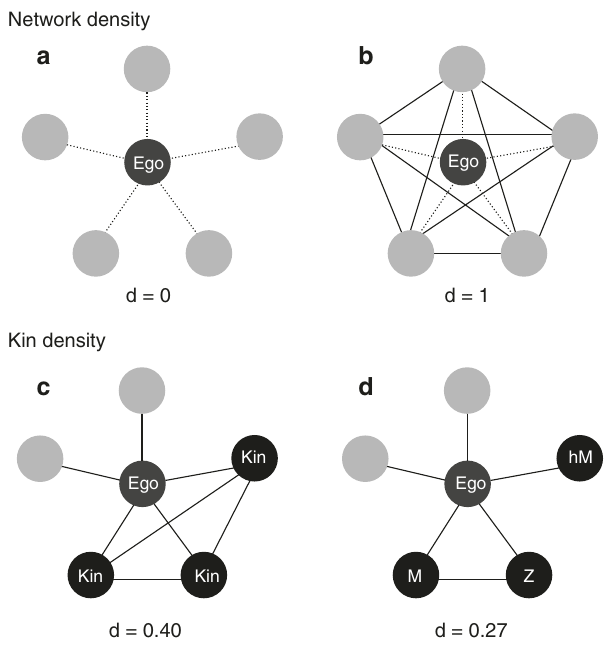
Fig. 2 Differences between network density, kin density and the proportion of kin. a shows a sparse ego-network ( d = 0, i.e. no ties present) and b a fully dense one ( d = 1, i.e. all possible ties present). Ego ’ s connections to the alters are not counted (dashed lines). c shows a moderately kin-connected network ( d = 0.4, i.e. 40% of all possible ties are kinship ties), where the proportion of kin is 0.6. Ego ’ s kinship connections to the alters are counted. d shows kinship density for the same network when af fi nal kin (hM = husbands mother) are distinguished from consanguineal kin, reducing the number of kin ties (M = mother; Z = sister; d = 0.27, i.e. only 27% of ties are kinship ties). Counting the proportion of kin in the network is not equivalent to counting the density of kin